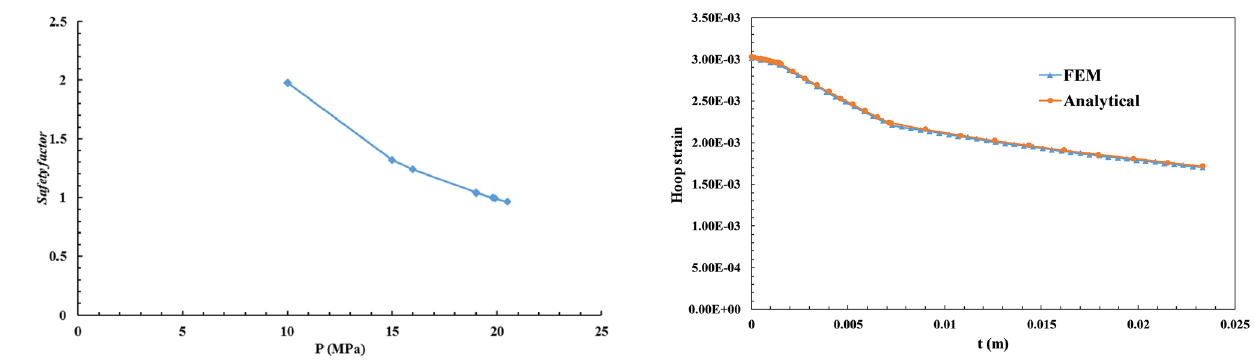
Fig. 8 Comparison of the analytical and FEM hoop strain in the burst pressure of the repaired pipe